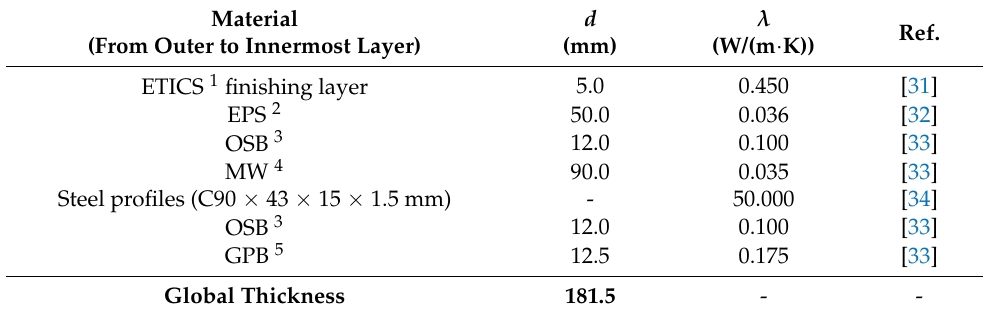
Figure 1. Reference facade LSF wall horizontal cross-section: materials and geometry. Table 1. Reference facade LSF wall material thickness ( d ) and thermal conductivities ( λ ). Material